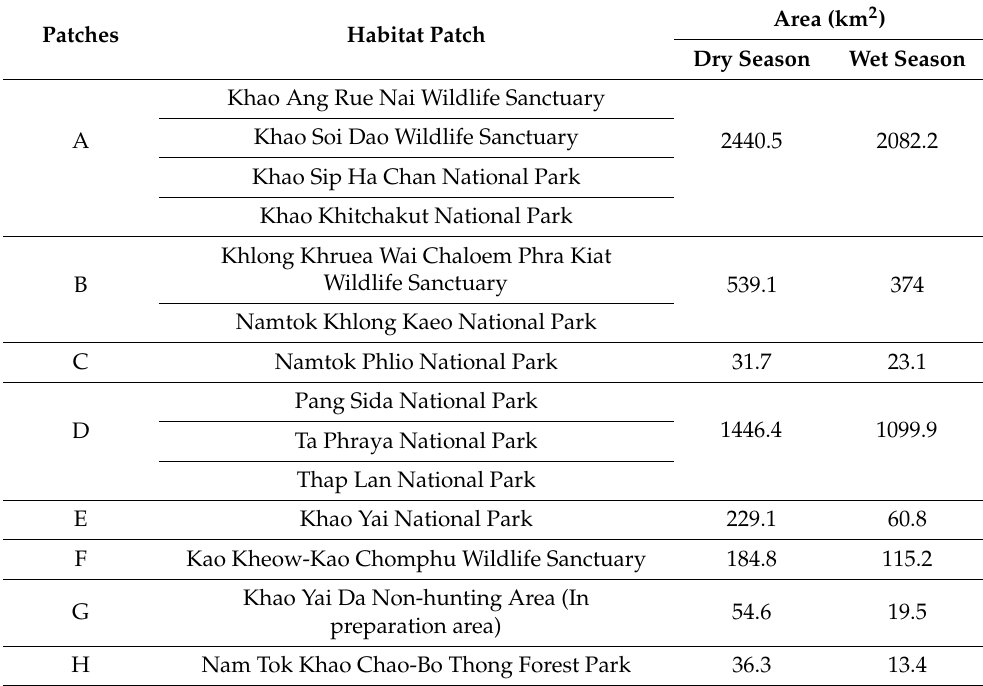
Table 2. The area of eight important habitat patches of wild elephants in the eastern part of Thailand.